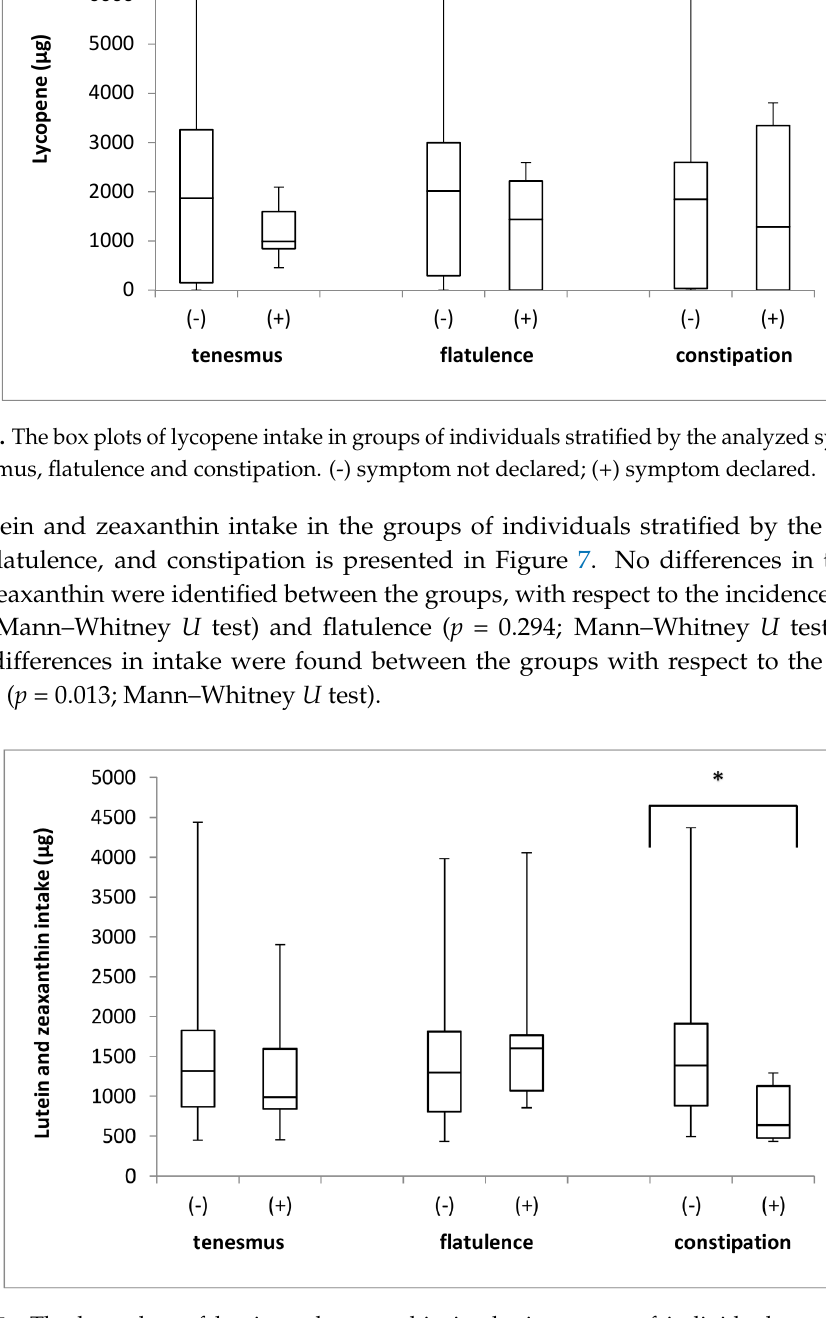
Figure 7. The box plots of lutein and zeaxanthin intake in groups of individuals stratified by the analyzed symptoms of tenesmus, flatulence and constipation. (-) symptom not declared; (+) symptom declared.